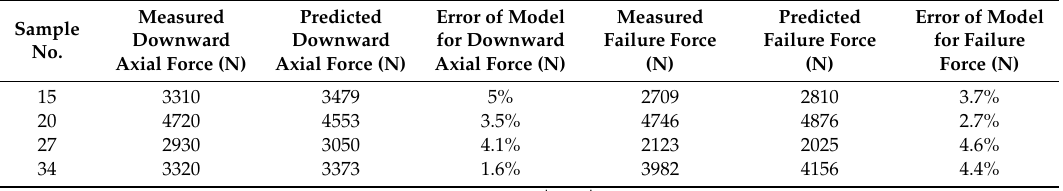
Table 8. The amount of experimental data, predicted data and its error for the confirmation experiments. Sample